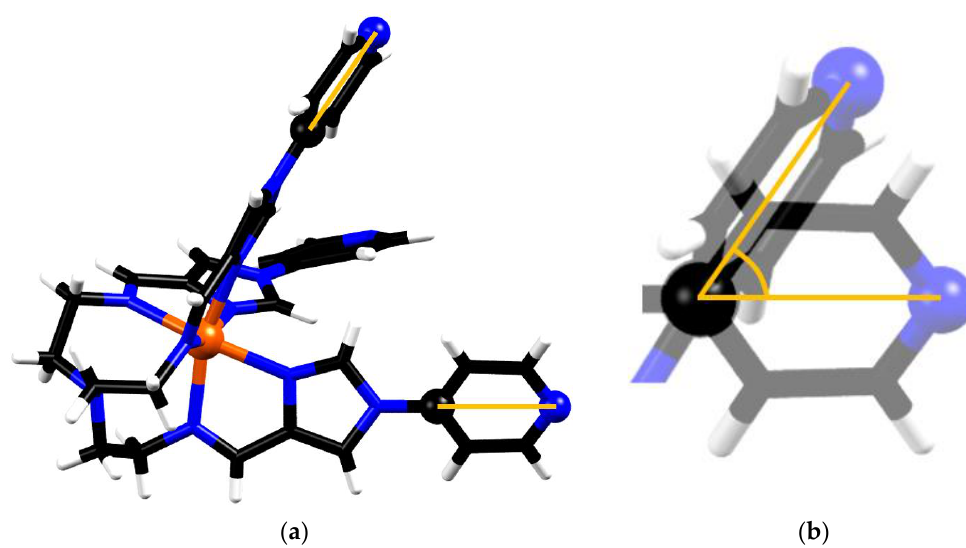
Figure 6. Representation of two selected mutually-positioned secondary group bonding axes in the metalloligand. ( a ) the intervals corresponding to the bonding direction of each of the secondary binding domains are highlighted, as defined by the coordinates of C9 and N4 in each arm of the metalloligand. ( b ) Since the bonding axes do not intersect, they are translated such that the reference C atoms in both ligand arms share the same point. The angle between axes can then be calculated.